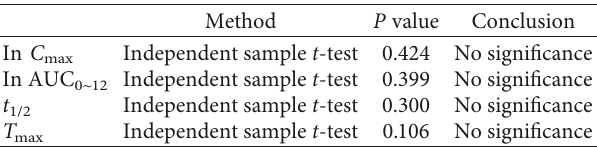
Table 6: Main pharmacokinetic parameters for the statistics and analysis ( n � 8).